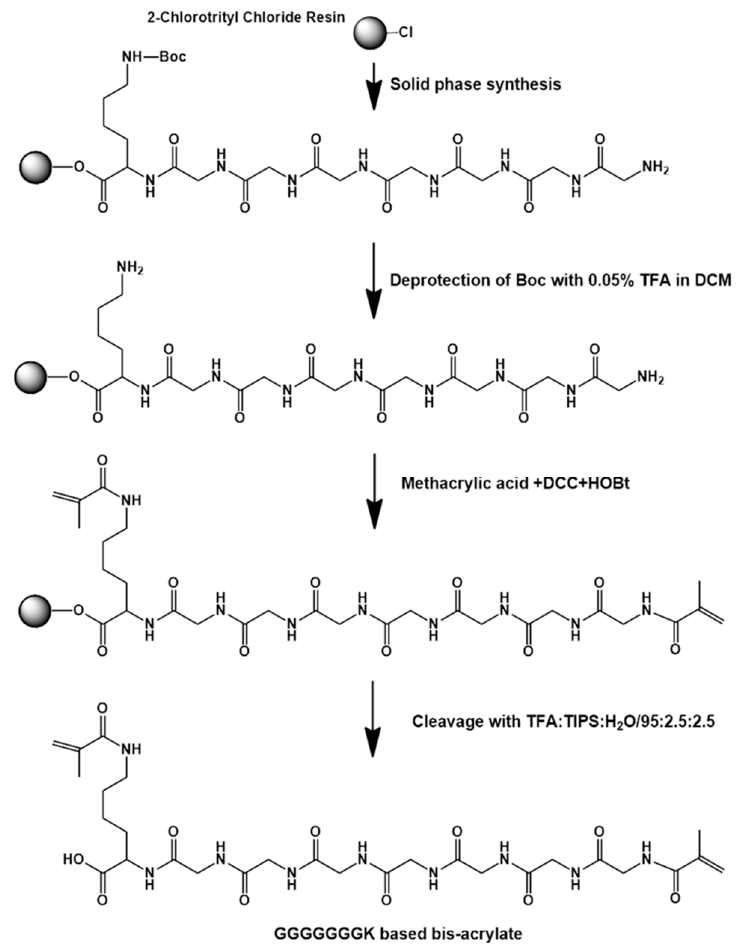
Figure 2. Schematic diagram of the peptide-based bis-acrylate as a crosslinker. The peptide sequence Lys-Gly-Gly-Gly-Gly-Gly-Gly-Gly was synthesized using the solid-phase synthesis method. The peptide-based crosslinker was synthesized directly on the peptidyl resin by coupling AAc to the amine groups.